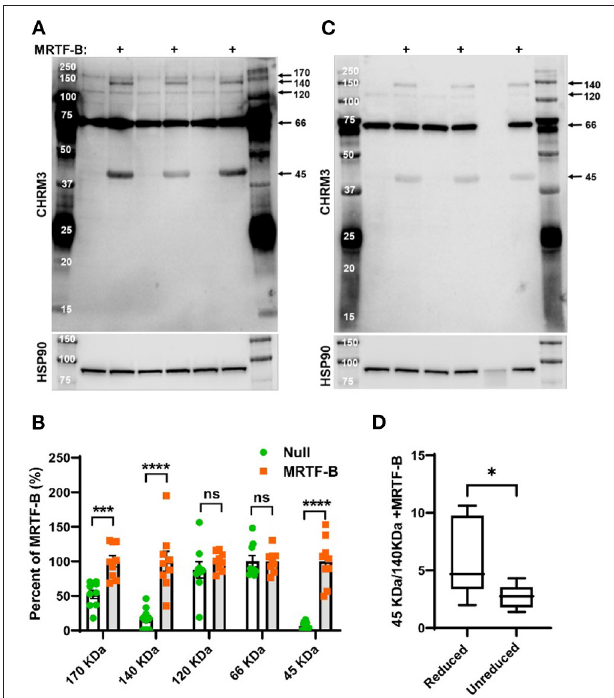
FIGURE 4 | MRTF-B increases CHRM3 immunoreactive bands in human coronary artery smooth muscle cells. Protein lysates from human coronary artery SMCs treated with null virus and with MRTF-B virus for 120h, respectively, were used for Western blotting using an antibody raised against a human CHRM3 in (A) . After developing the blot, it was stripped and incubated with HSP90 antibody (shown below) to assess equal protein loading. At least five bands were detected with the CHRM3 antibody, and three bands at ≈ 170, ≈ 140, and ≈ 45 kDa changed significantly with MRTF-B as shown in the compiled analysis in (B) . Quantification in (B) was done using the blots in (A) . Proteins from the same original lysates were also prepared in non-reducing conditions, to examine if the relationship between bands changed (C) . The volume was insufficient for one of the null samples in this experiment (lane 6). Non-reducing conditions favored the 140 kDa band at the expense of the 45 kDa band (D) , suggesting multimerization. **** p < 0.0001, *** p < 0.001, and * p <